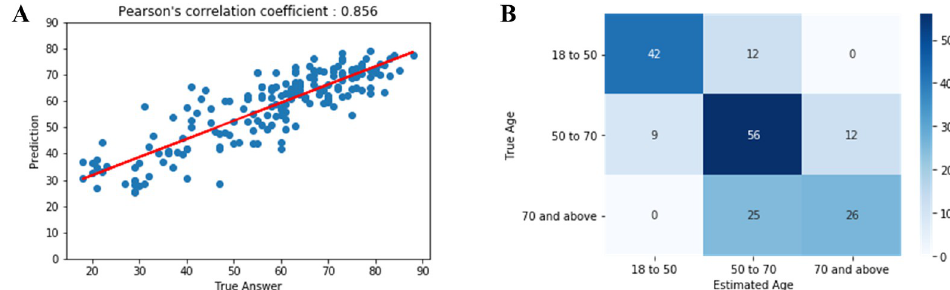
Fig 2. Predicted age based on CAG imaging versus chronological age. A Estimated vascular age versus reported chronological age (in years; red, regression line). R squared for the model was 0.72 with a Pearson correlation of r = 0.856. B Patients were classified by age (in years) into groups of 18 to 50, 50 to 70, and over 70 years, and the number of patients of a given actual age (y axis) classified into each estimated vascular age (x axis) was shown to confirm accuracy. The overall accuracy was